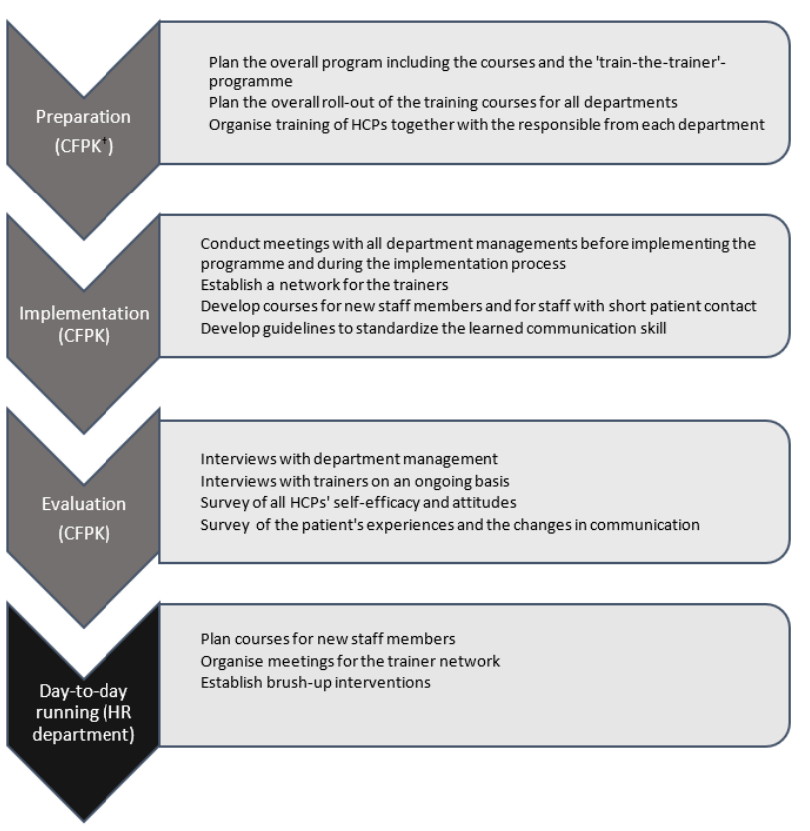
Figure 1. Overview of the entire implementation process. † CFPK: Centre for Research in Patient Communication, Odense, Denmark.